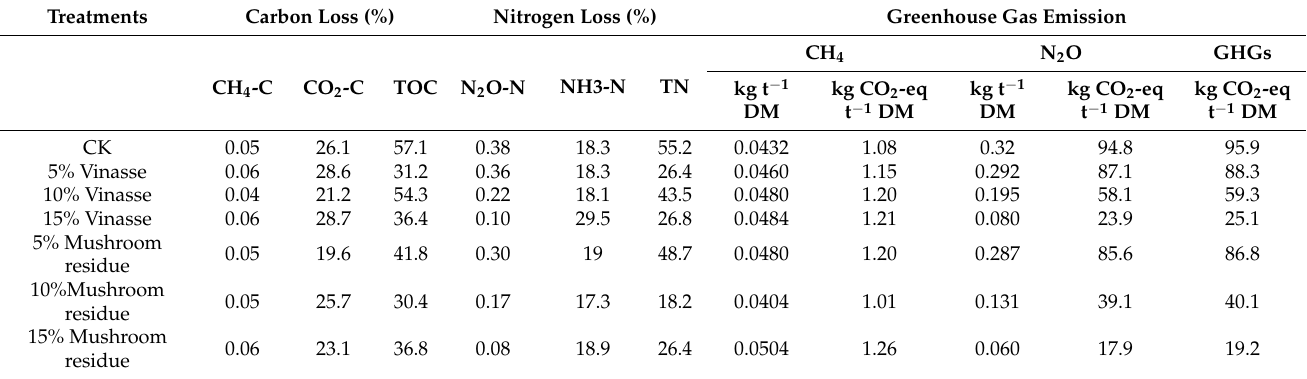
Table 4. Analysis of carbon and nitrogen balance during